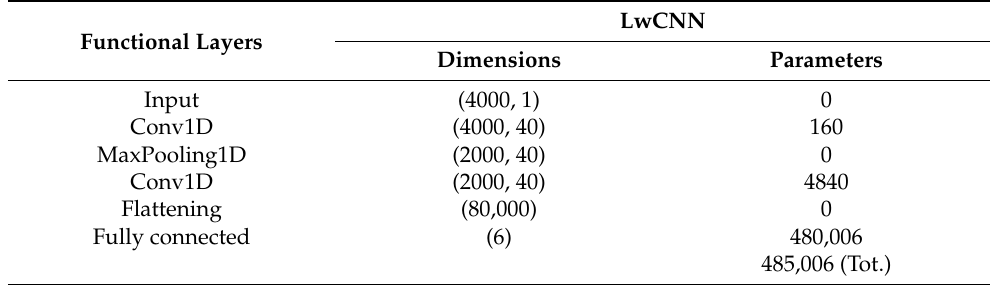
Table 2. The dimensions and trainable parameter numbers of LwCNN when M , n , and λ were set as 40, 3, and 0.6,